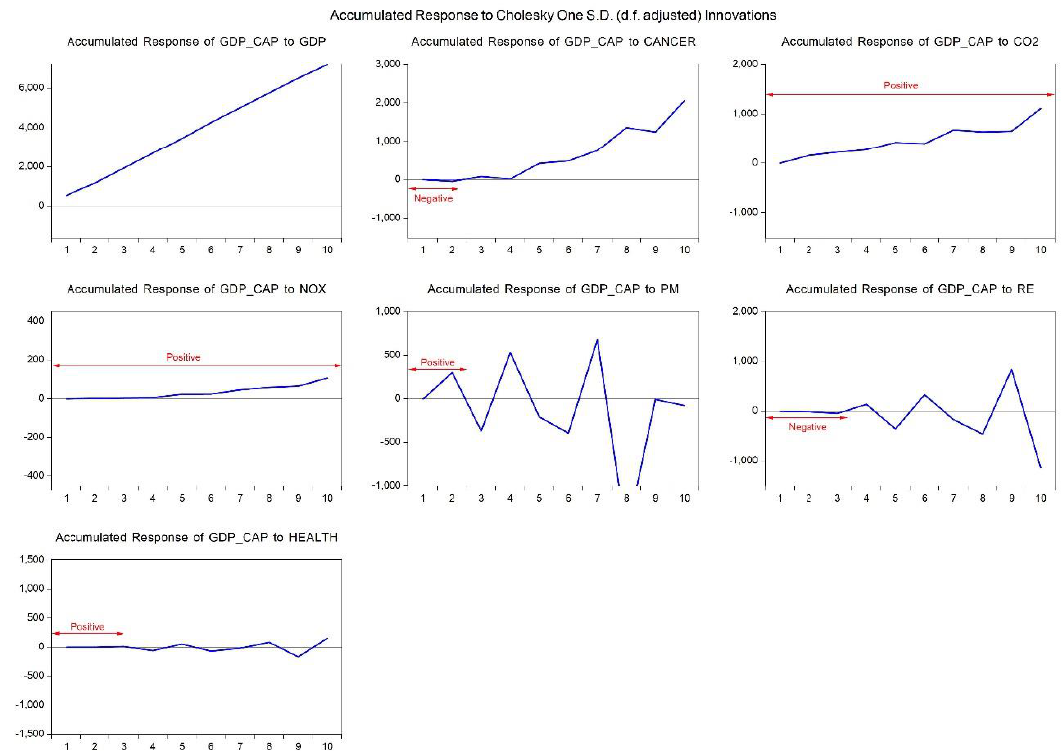
Figure 5. Response of GDP_CAP. Note: Vertical axis is the accumulated response of GDP_CAP to Cholesky one standard deviation innovations, horizontal axis is period of time. Source: Authors’ compilation from Eviews 10.00. Table 8. Variance decomposition of